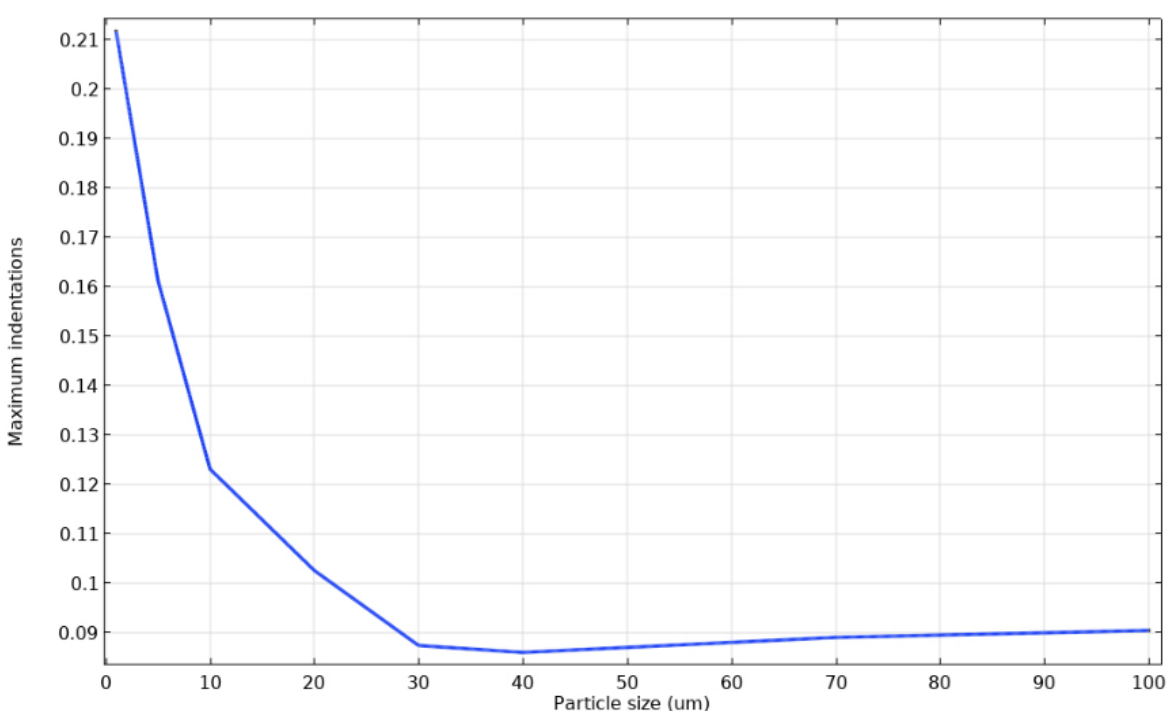
Figure 7. Variation of nondimensional indentations h/d against particle size.